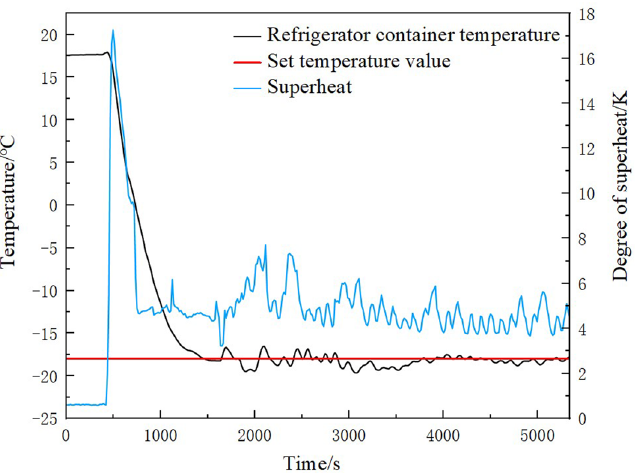
Figure 14. The change of refrigerator container temperature and superheat in the cooling experiment.